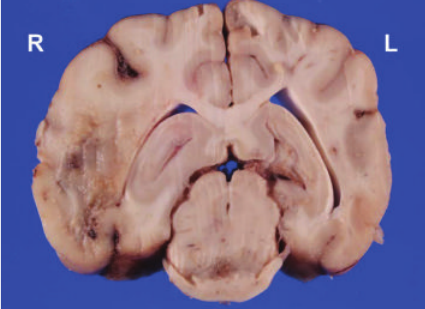
Figure 3: Macroscopic appearance of the cut surface of the brain at the level of the midbrain on postmortem examination. A focus of malacia is identified in the right piriform lobe.